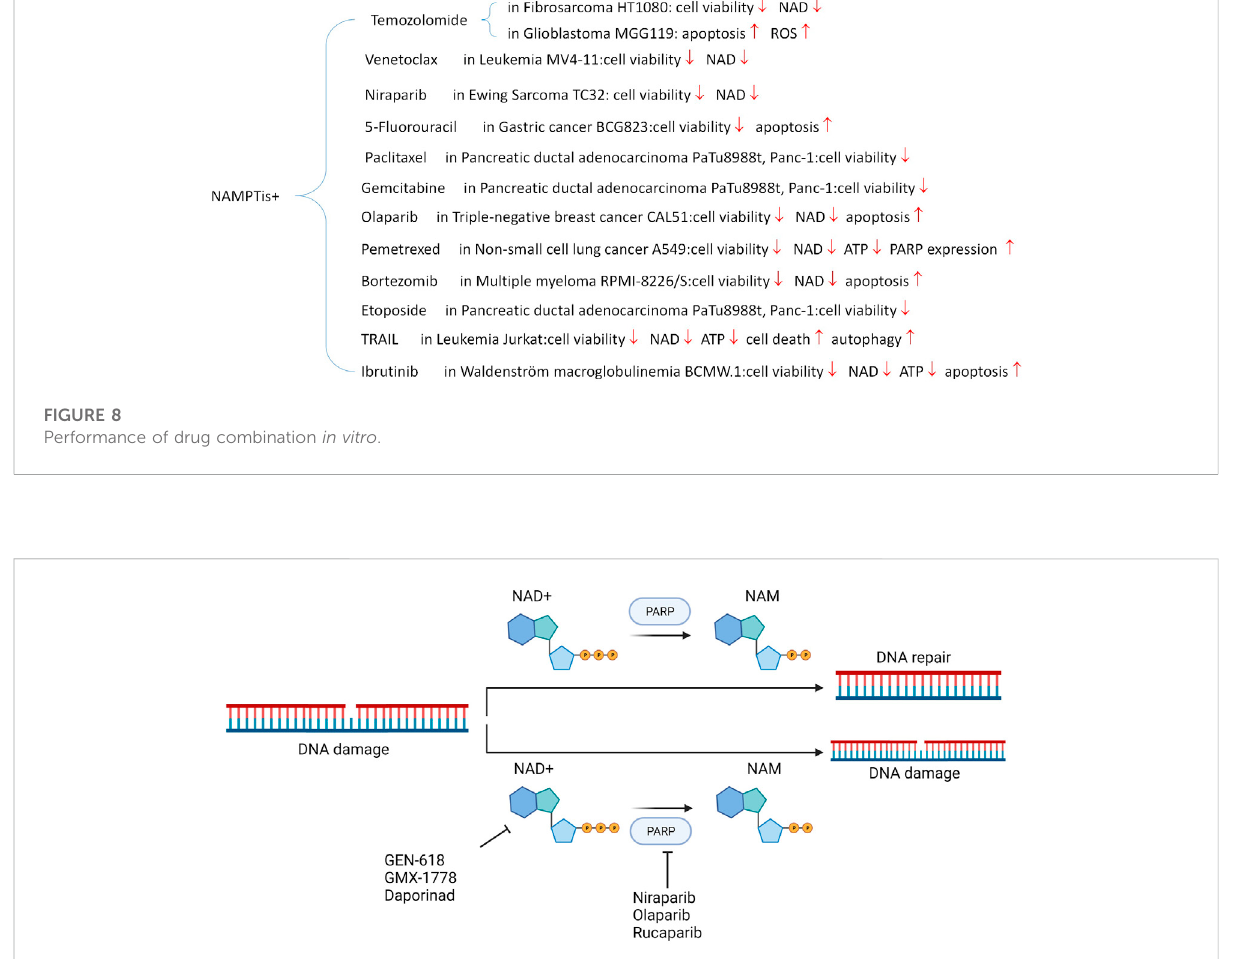
FIGURE 9 Theoretical basis of simultaneous targeting of PARP and NAMPT in tumor